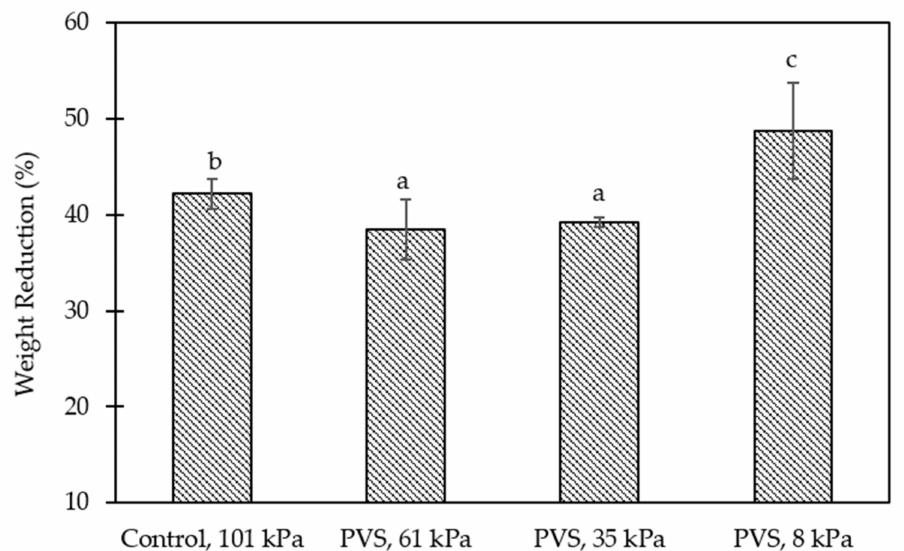
Figure 2. Effect of working pressures on the weight reduction (WR, %) of calcium-alginate hydrogel balls after stimulating for 3 cycles (1 cycle of control = 60 min of soaking during the external gelation process, while 1 cycle of PVS = 10 min of depressurization and 10 min of vacuum liberation for 3 repetitions (60 min)). Means ( ± standard deviation) within a bar graph followed by different lower-case letters, differ by least significant difference (LSD) test ( p < 0.05).